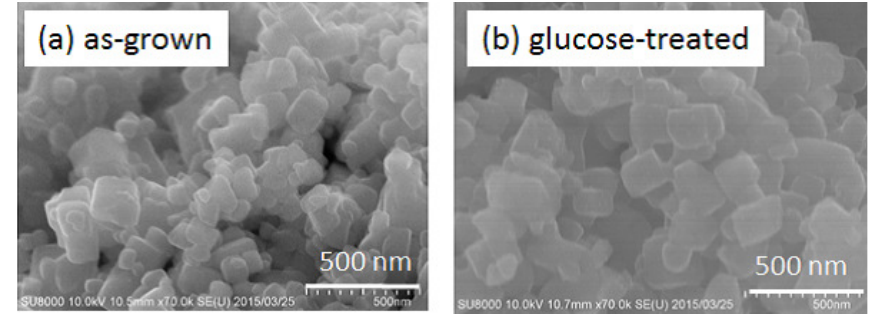
Figure 1. SEM images of ( a ) as-grown and ( b ) glucose-treated Manganese hexacyanoferrates (Mn-PBAs).